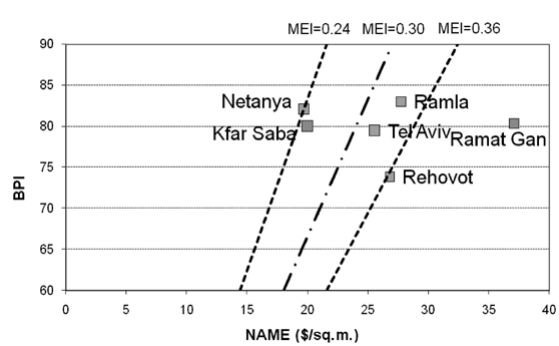
Figure 4. BPI Vs. NAME for the public facilities sample